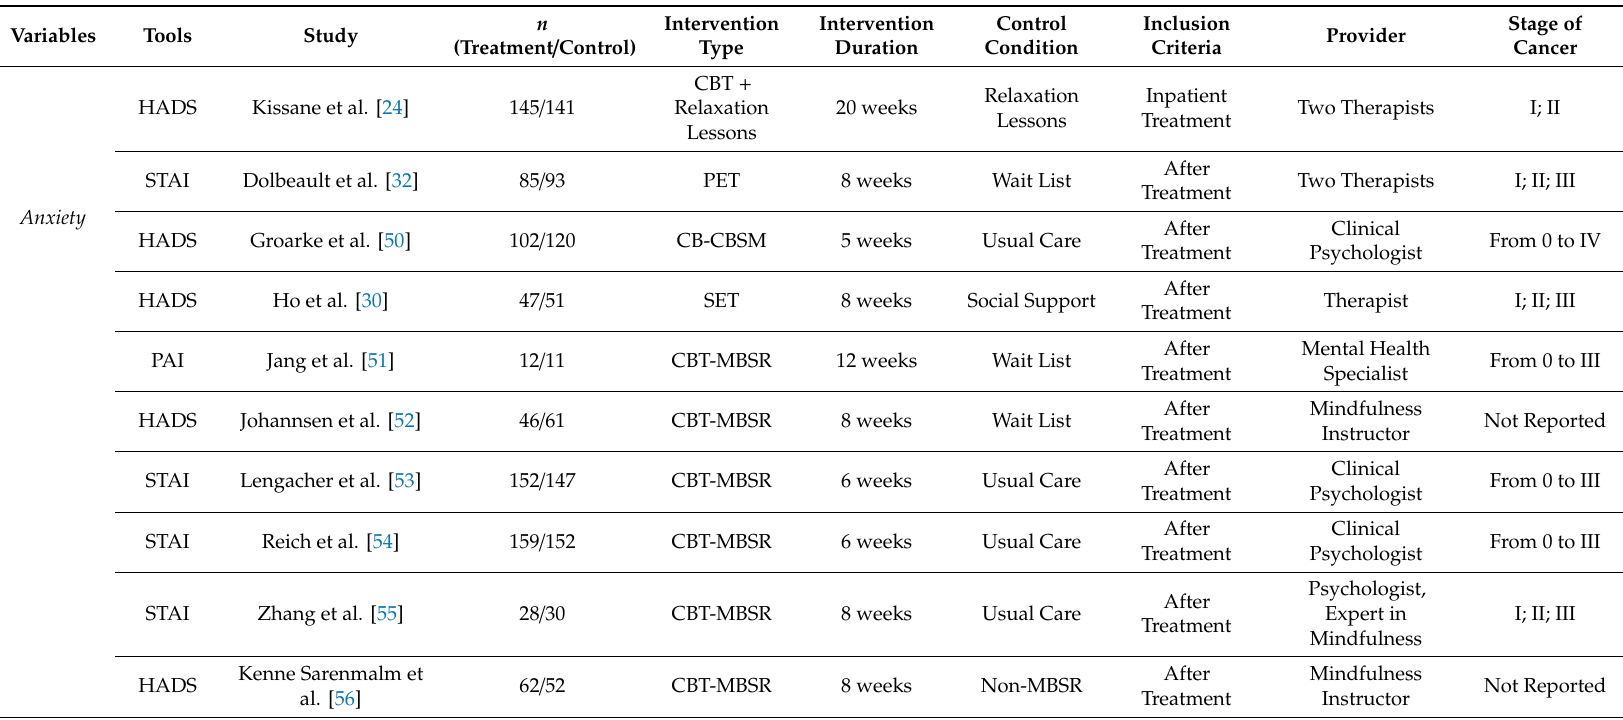
Table 1. Information about the studies included in the meta-analysis. For each study, the following variables are reported: the outcome and the instruments (Tools) utilised to evaluate it; the sample size ( n ); the Intervention Type; the Intervention Duration; the Control Condition; the Inclusion Criteria; the Provider; and the Stage of